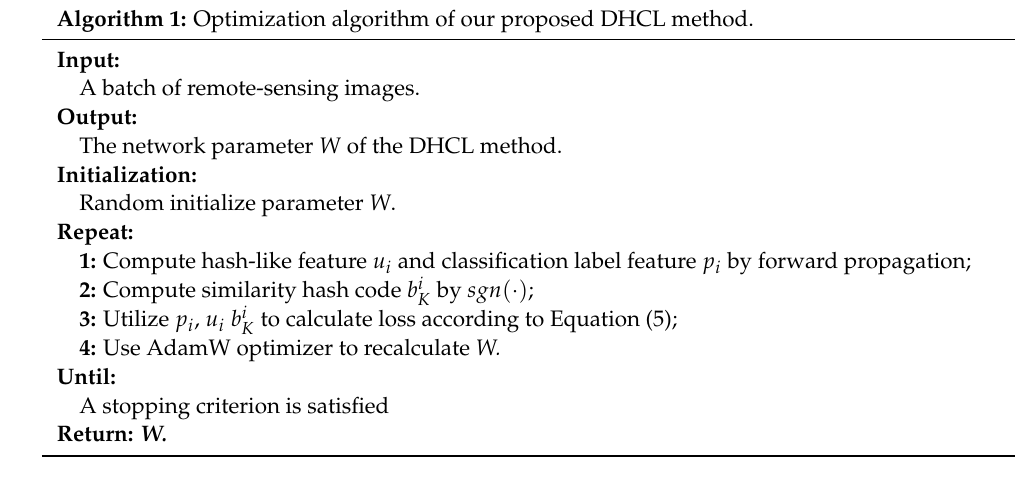
Algorithm 1: Optimization algorithm of our proposed DHCL method.